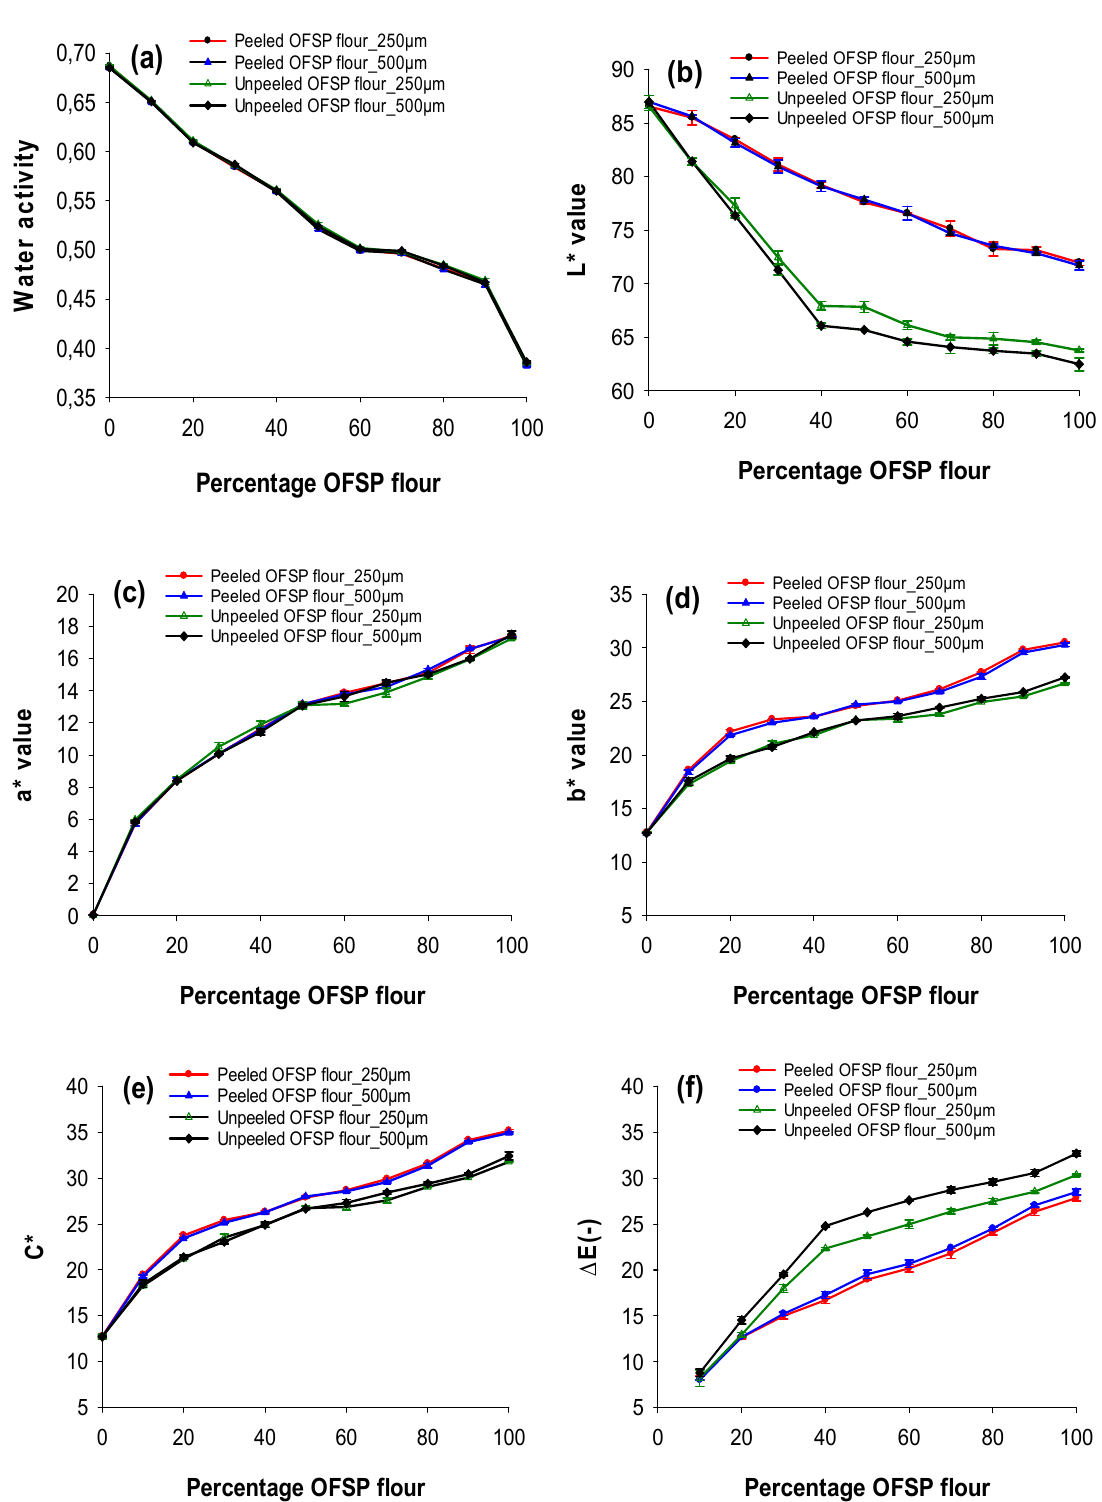
Figure 2. Effect of sieve particle size and blend proportion on the physical properties of peeled and unpeeled OFSP composite flours. ( a ) Water activity; ( b ) L* (lightness); ( c ) a* (redness); ( d ) b* (yellowness); ( e ) C* (Chroma); ( f ) ∆ E ( − ) (total colour difference). Values are expressed as means ± standard deviation ( n = 5). Significant difference between means was determined at p < 0.05.